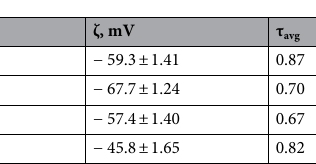
Figure 2. ( a ) Excitation and luminescence spectra of PSS-[Tb 2 (TCAn) 2 ] ((λ ex , (nm (n)) = 351 (1), 355 (2), 363 (2) and 367 (4)) nanoparticles in H 2 O and ( b ) [Tb 2 (TCAn) 2 ] (λ ex , (nm (n)) = 367 (1), 373 (2), 380 (3) and 388 nm (4)) in DMF. C = 0.75 mM for all of the samples. Normalized intensity of the luminescence band at 545 nm ( c , d ) and excited state lifetimes ( e , f ) of PSS-[Tb 2 (TCA1) 2 ] ( c , e ) and PSS-[Tb 2 (TCA2) 2 ] ( d , f ) in water monitored within the range of temperatures 293–333 K upon heating (black) and cooling (red).